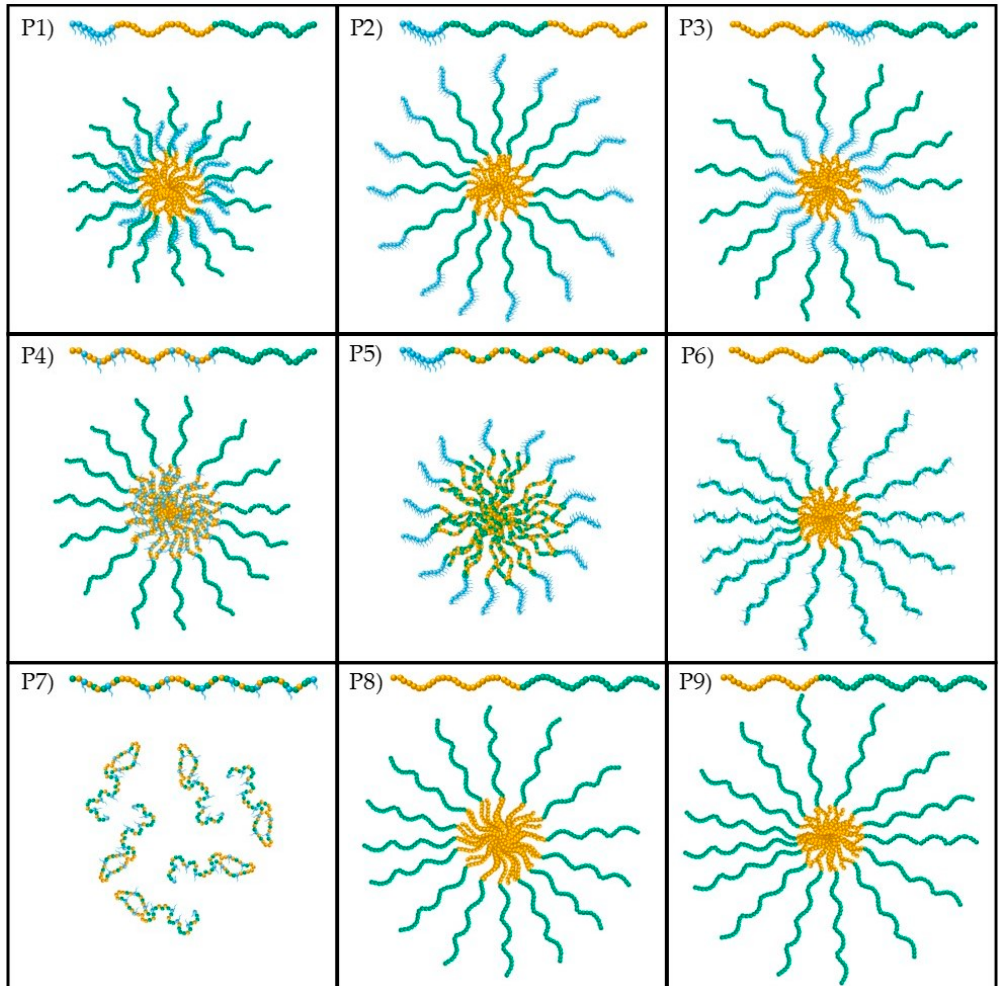
Figure 4. Schematic showing the structures of the spherical micelles adopted by the block copolymers (Polymers 1–6, 8, and 9). The random coil formed by the statistical copolymer (Polymer 7) is also shown. The TEGMA, BuMA, and DMAEMA units are colored in blue, orange, and green, respectively.